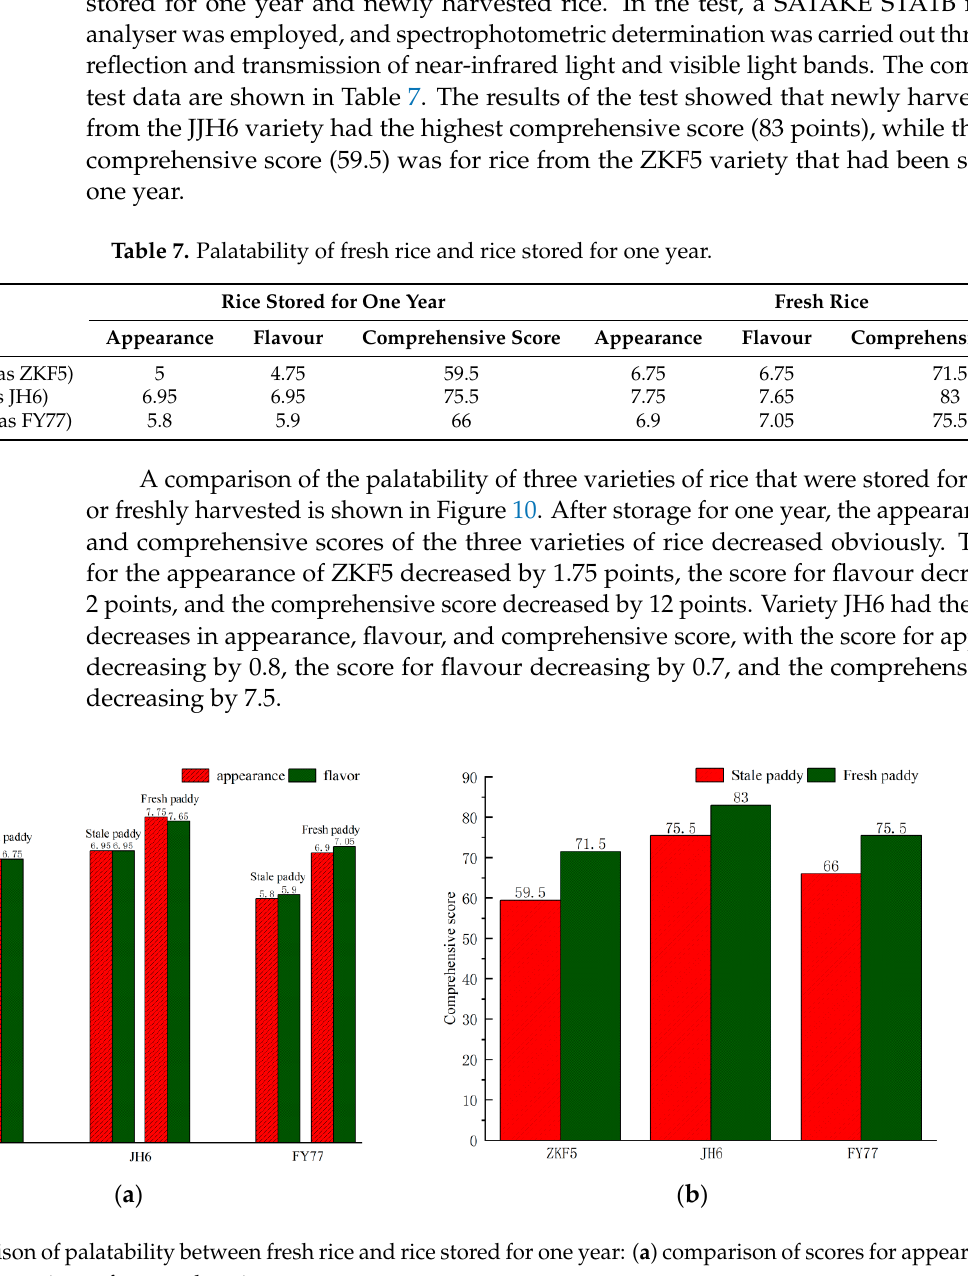
( b ) Figure 11. Comparison of the microstructures of newly harvested rice and rice stored for one year: ( a ) microstructure of fresh rice; ( b ) microstructure of rice stored for one year. Although there has been a rapid development of storage technologies, the devel- opment has been unbalanced geographically, and storage technology is still in the stage of being both basic and advanced. According to preliminary estimates, the losses caused by farmers using traditional methods of grain storage can reach 9% [18], while the losses of grains stored long term can reach more than 10%. The T 5 storage period is the most important stage after grain harvesting. Having moisture in granaries and stored rice is not always safe. Microorganisms and pests can consume nutrients from rice grains during storage, and improper grain storage will cause changes in grain quality. A large number of microorganisms produce mycotoxins, which render grain useless [99,100]. The 5T management method states that appropriate control measures, such as the application of advanced grain storage technologies and low-temperature storage, should be adopted. For the highest palatability, the tempera-